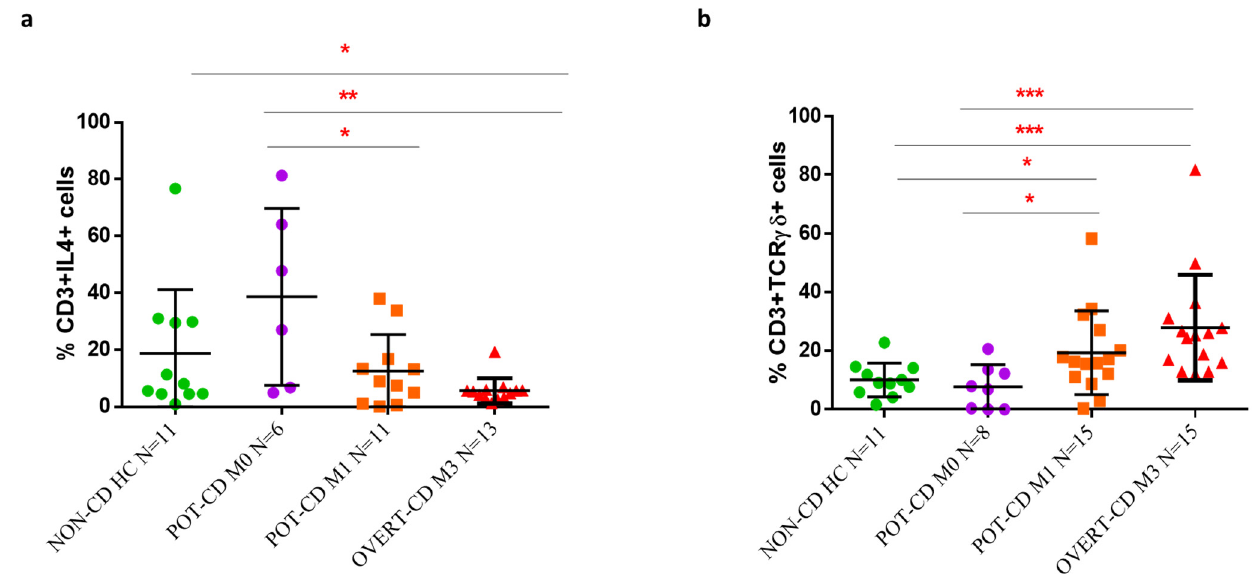
Figure 2. Frequency of TCR γδ + T cells and IL4+ T cells in CD patients stratified on the base of intestinal inflammation degrees. ( a ) Percentages of IL4-producing T cells and ( b ) CD3+TCR γδ + cells evaluated, by flow cytometric analysis, in intestinal mucosa (both ex vivo and in vitro approach) of non-CD controls, potential-CD with Marsh score M0, potential-CD with Marsh score M1, and overt-CD with villous atrophy (Marsh score M3). Data are shown as single data and mean and standard deviation of all experiments. Statistical analysis was performed using a Mann-Whitney test by GraphPad Prism Software, with a p ≤ 0.05 considered statistically significant and labelled with asterisk * p < 0.05, ** p < 0.01, *** p < 0.001.